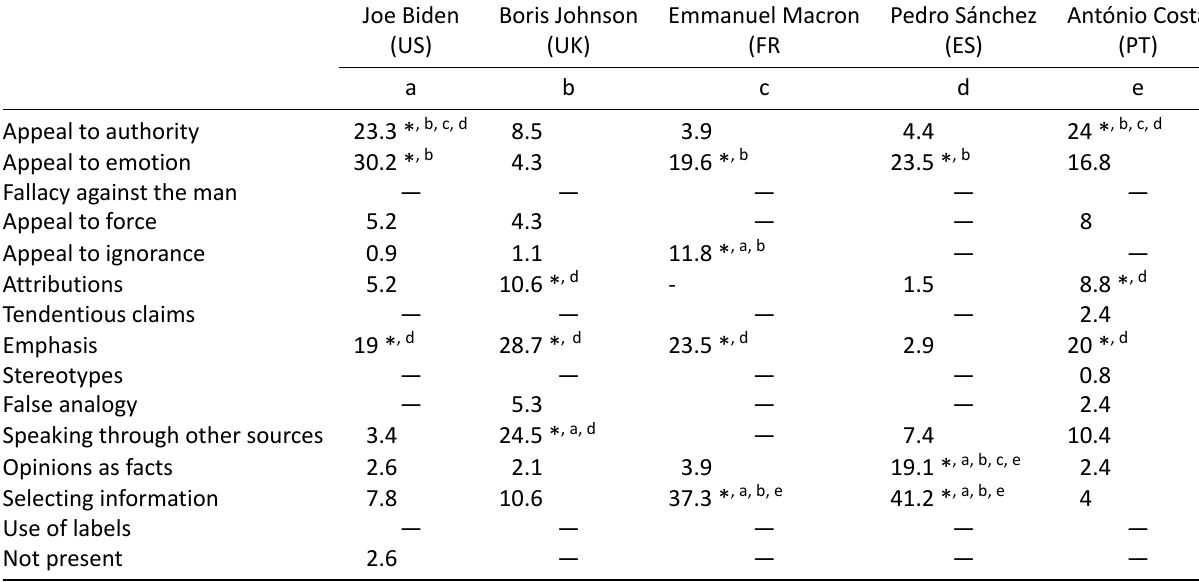
Table 4. Propaganda mechanisms on Twitter by leader (%).